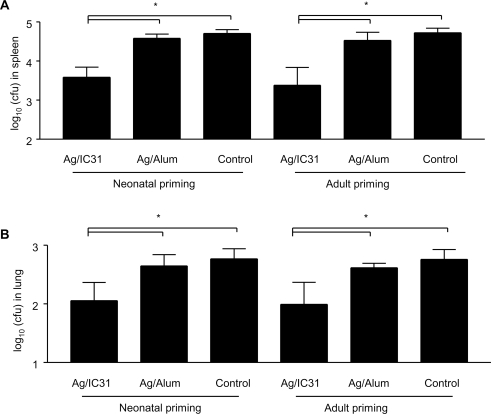
Ag85B-ESAT-6/IC31® protects neonates and adults from mycobacterial infection.Immunized neonatal and adult mice were challenged with Mycobacterium bovis BCG i.v. The CFU in spleen (A) and lung (B) (mean±SD, n = 6–8/group) were determined four weeks later, and is representative of 2 independent experiments. *, p<0.05, differences between IC31® and Alum or control were significant.